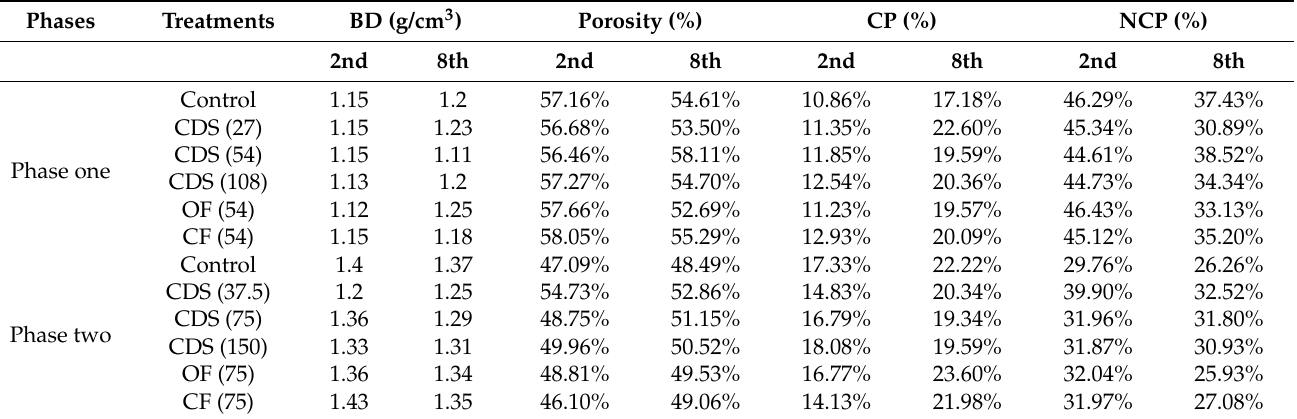
Table 4. Soil physical properties of the different treatments in the 2nd and 8th